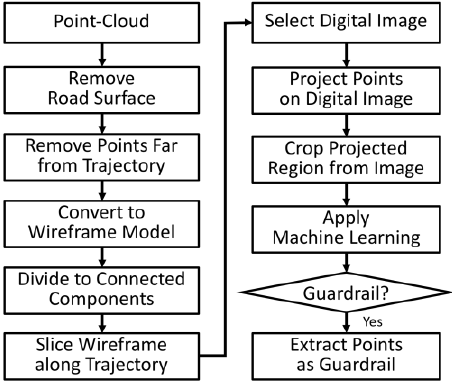
Figure 3. Process of extracting guardrail points